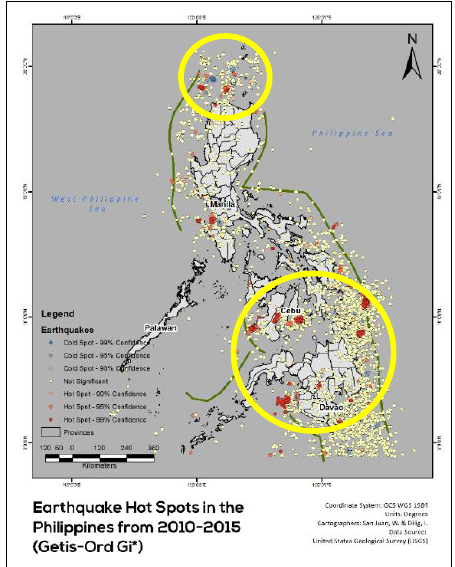
Figure 18. Earthquake Hot Spots in the Philippines from 2010 to 2015 (Getis-Ord Gi*) The areas emphasized in yellow circles show the hot spots from 2010 to 2015. These patterns can be seen in the prediction output of the study (green to yellow